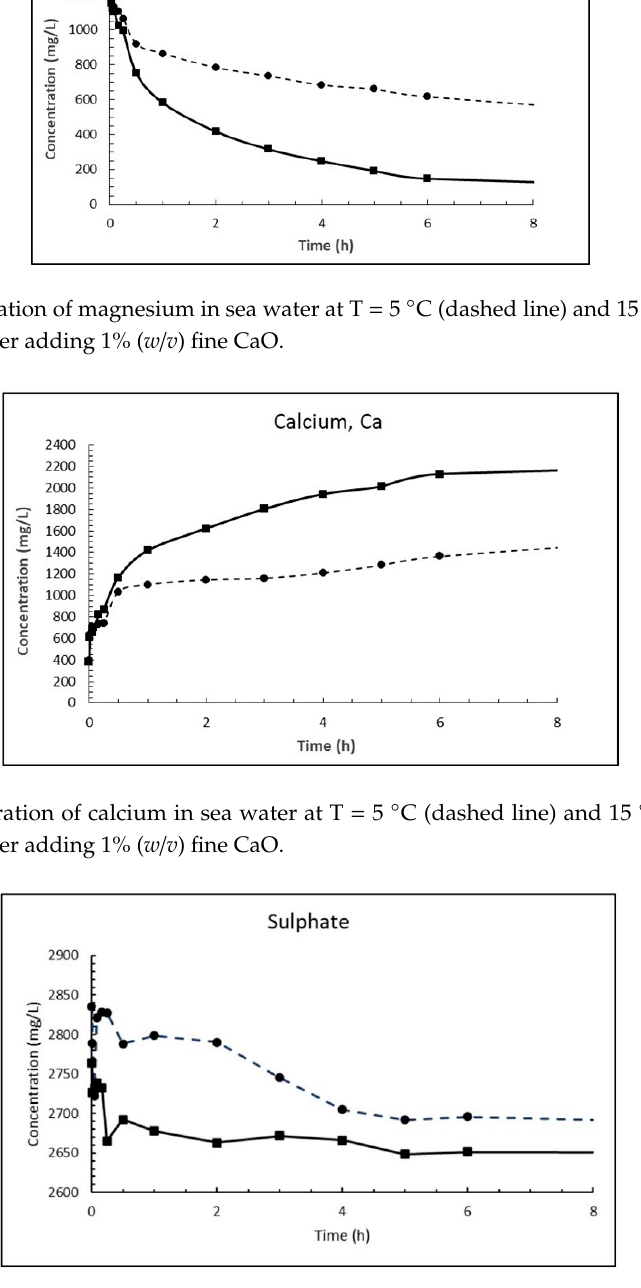
Figure 9. Concentration of sulphate in sea water at T = 5 °C (dashed line) and 15 °C (solid line) as function of time after adding 1% ( w / v ) fine CaO.